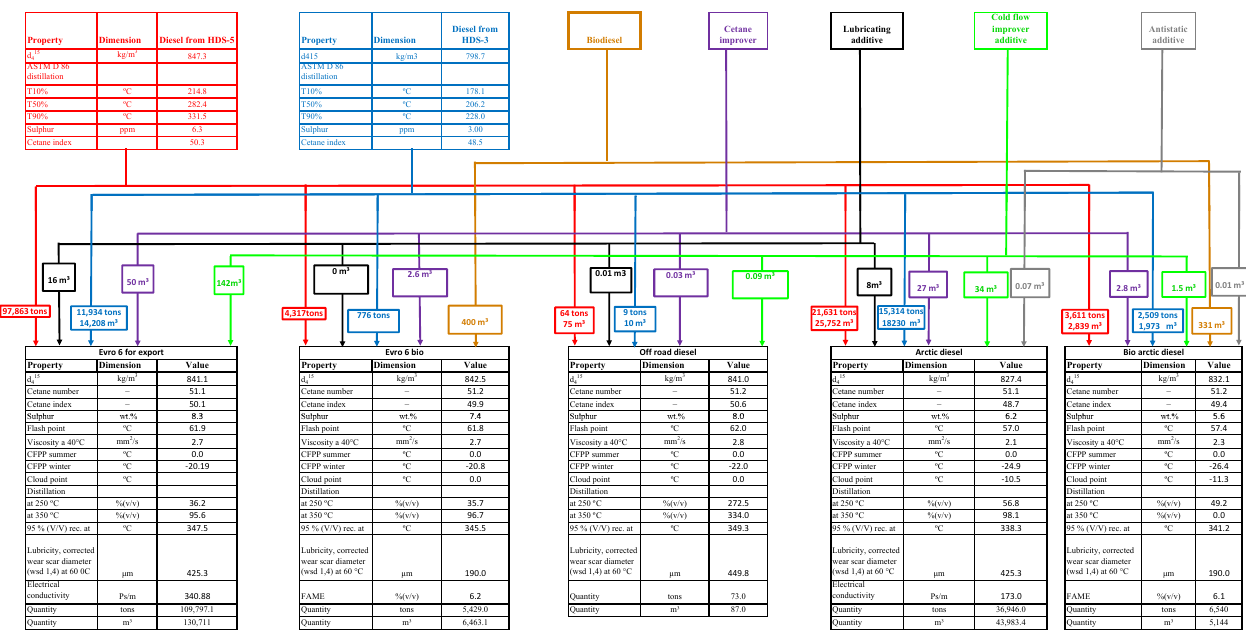
Figure 2. Production scheme of diesel fuel grades. The GN-transitions have the following